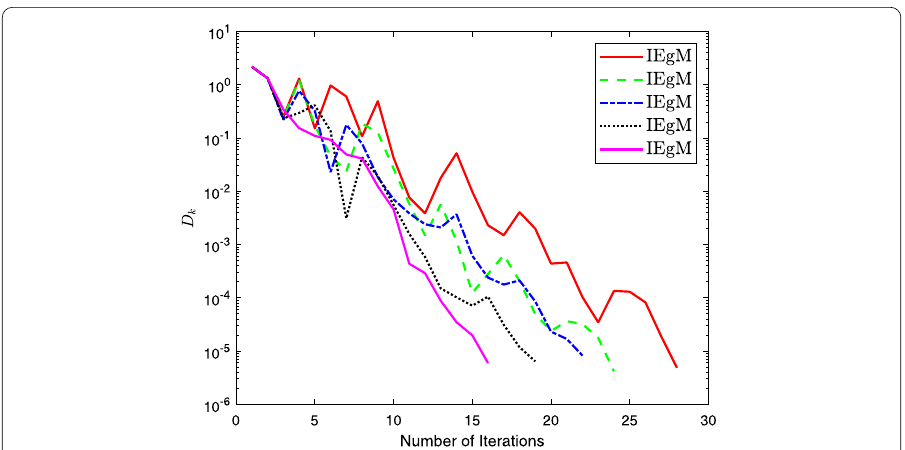
Figure 4 Computational performance of Algorithm 2 using different values of θ = 0.45,0.35,0.25,0.15,0.05, respectively